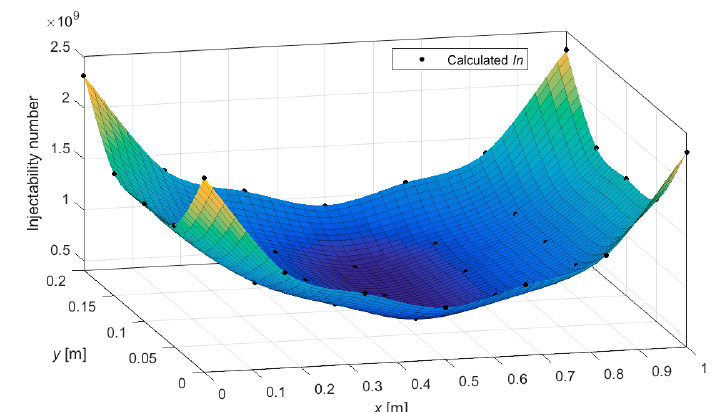
Figure 6. Injectability number as a function of inlet point coordinates in a rectangular mold cavity. The surface is obtained by interpolating the injectability numbers calculated on a grid of inlet positions using the same geometry and material parameters as in Section 4.